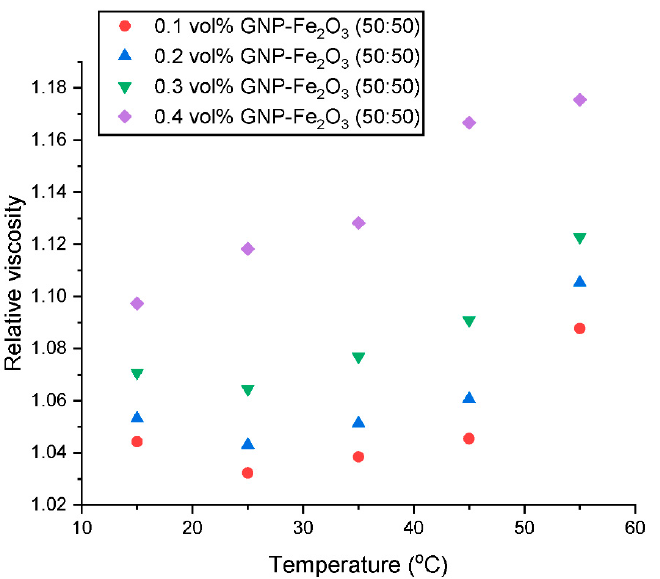
Figure 8. Influence of temperature on the relative viscosity of the hybrid nanofluids at various concentrations.